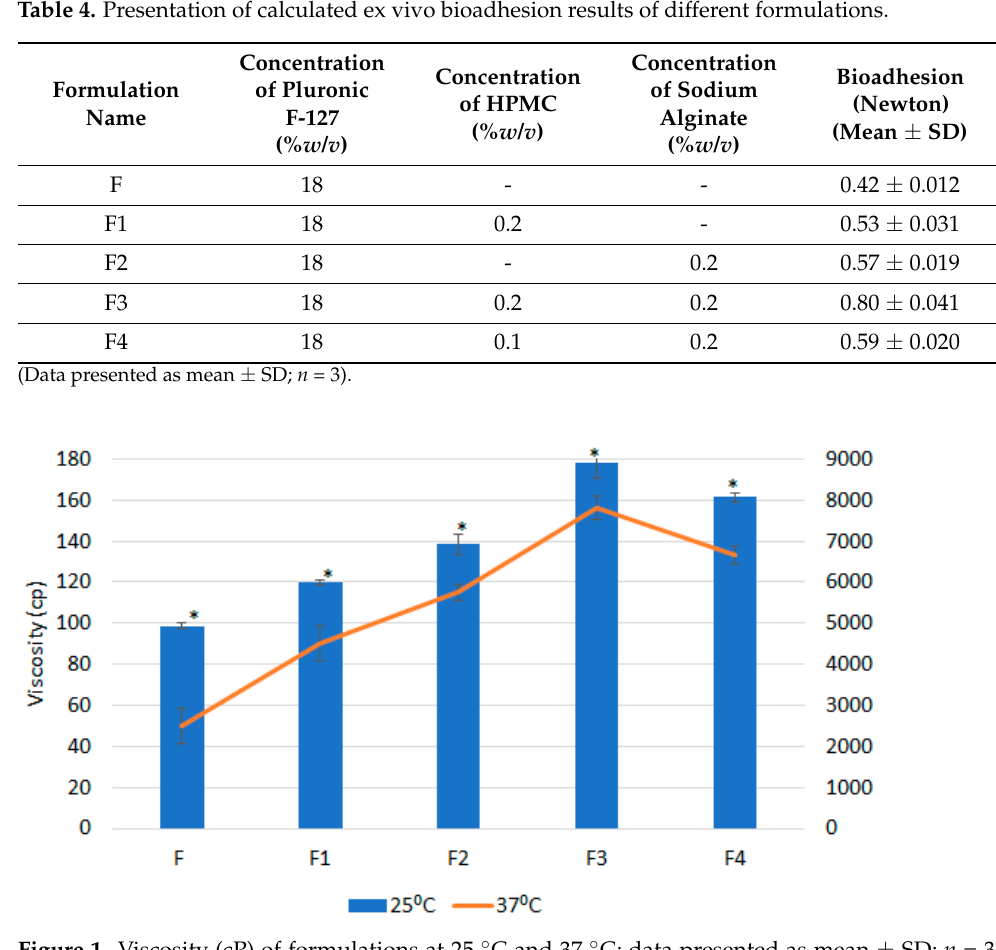
Figure 1. Viscosity (cP) of formulations at 25 °C and 37 °C; data presented as mean ± SD; n = 3; * indicates significant change in viscosity at 37 °C when compared to the corresponding viscosity at 25 °C ( p < 0.05).